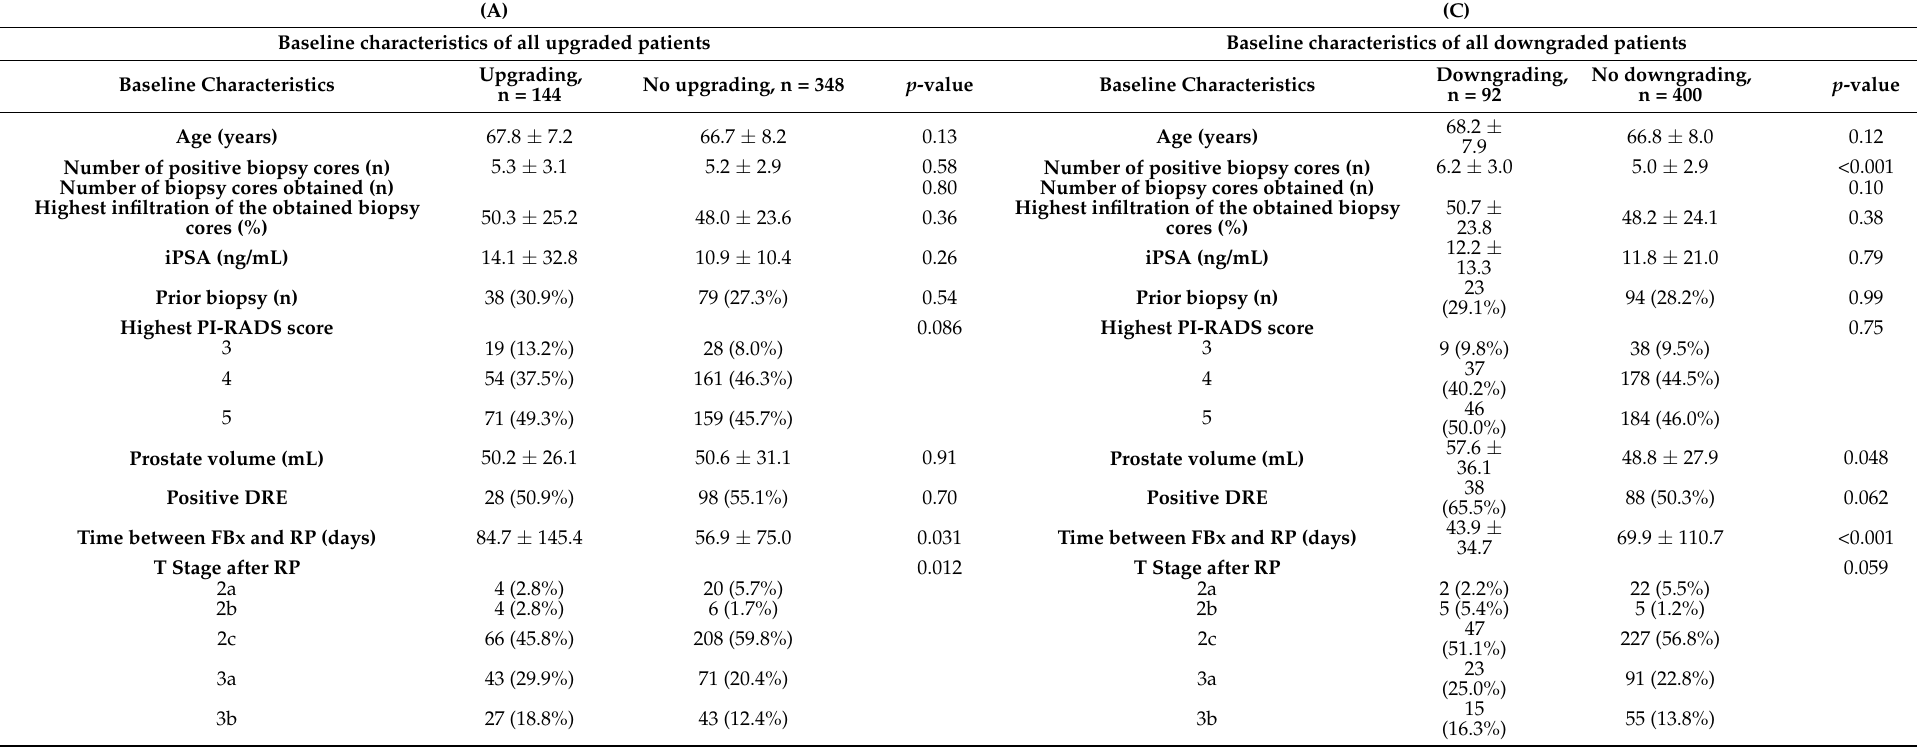
Table 5. Baseline characteristics, as well as univariate and multivariable logistic regression analyses, of all upgraded ( A , B ) and downgraded ( C , D ) FBx patients. Continuous variables are presented as mean and standard deviation. Categorical variables are presented in absolute numbers and relative numbers in percent. FBx: mpMRI fusion-guided biopsy of the prostate, RP: radical prostatectomy, iPSA: prostate-specific antigen at the time of RP, PI-RADS: Prostate Imaging Reporting and Data System, OR: odds ratio, CI: confidence